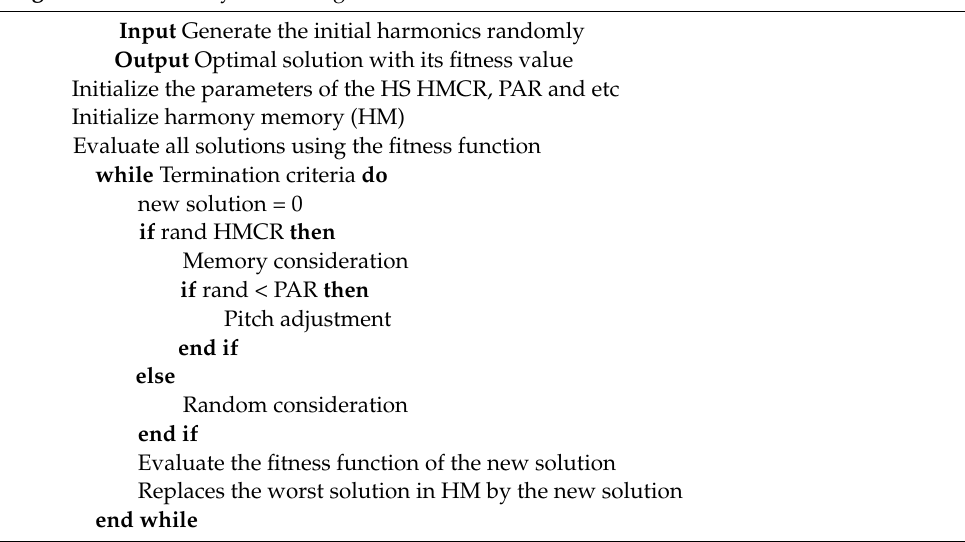
Algorithm 3 Harmony Search